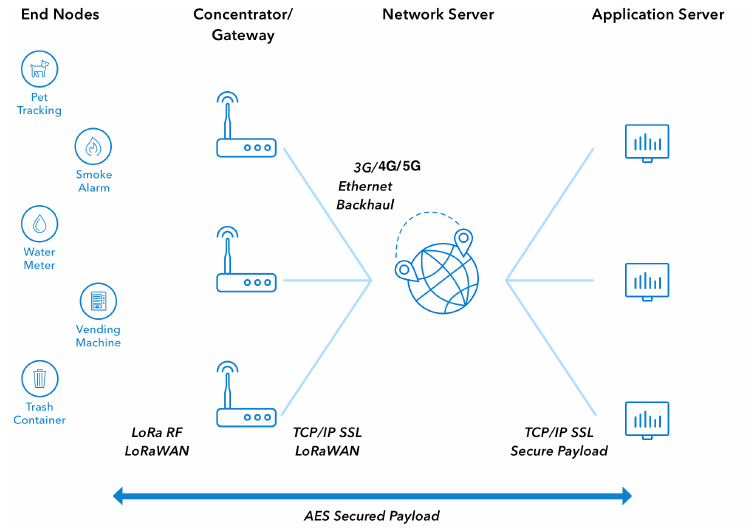
Figure 1. LoRaWAN network architecture.